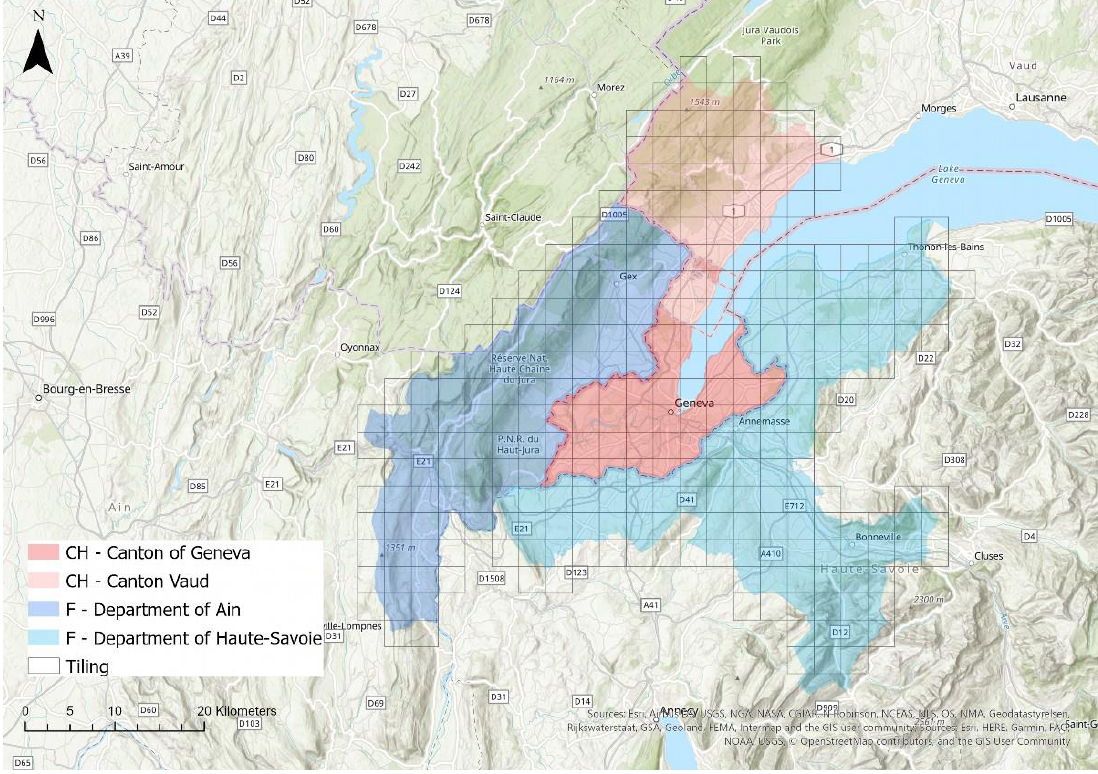
Figure 2. Geographical context of Greater Geneva area (main administrative boundaries and tiling).